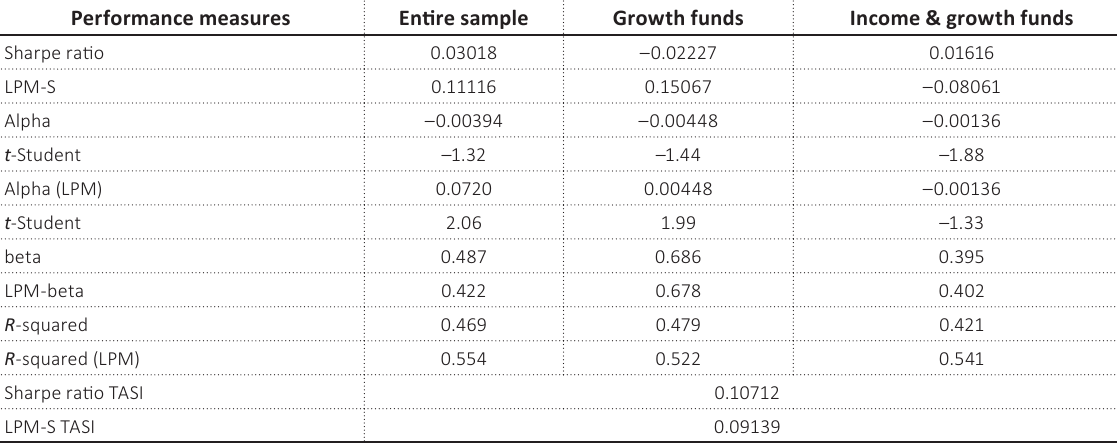
Table 2. Summary statistics on performance measurement by fund groups Performance